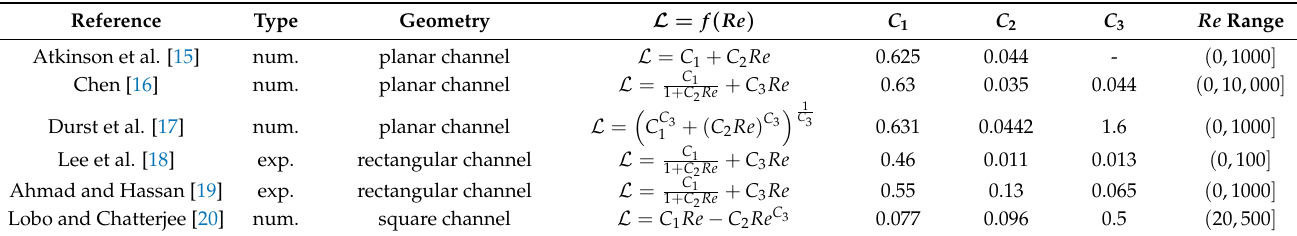
Table 1. Existing correlations to estimate L = f ( Re ) for low Re channel flows between parallel plates ( Re = ρ UL ∗ / η , with L ∗ representing the channel width). num. and exp. stand for numerical and experimental work, respectively.